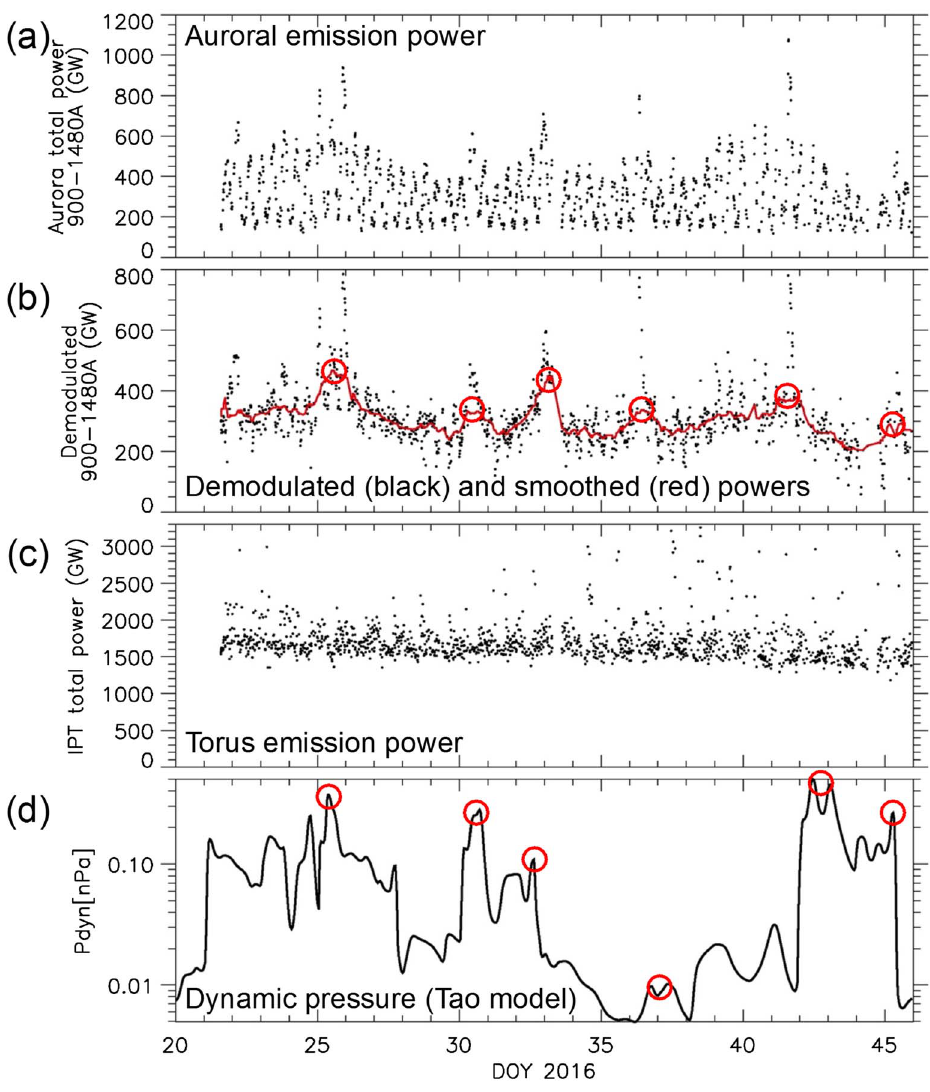
Fig. 12. Example of Hisaki monitoring of Jupiter ’ s aurora and plasma torus observed on DOY 21-46, 2016. (a) Emission power of Jupiter ’ s northern aurora. (b) Demodulated (black dots) and smoothed (red solid line) of auroral emission power (see Kimura et al. (2018) for the demodulation and smoothing methods). Local maxima in the smoothed power are indicated with red circles. (c) Emission power of the torus. It is of note that some data dots away from the monotonically decreasing trend are contaminated with the radiation background; this was observed when Hisaki fl ew through the Southern Atlantic Anomaly. (d) Solar wind dynamic pressure extrapolated from Earth ’ s orbit by a one- dimensional MHD simulation (Tao et al., 2005). Local maxima in the dynamic pressure closest to those in the smoothed auroral power are indicated by red solid